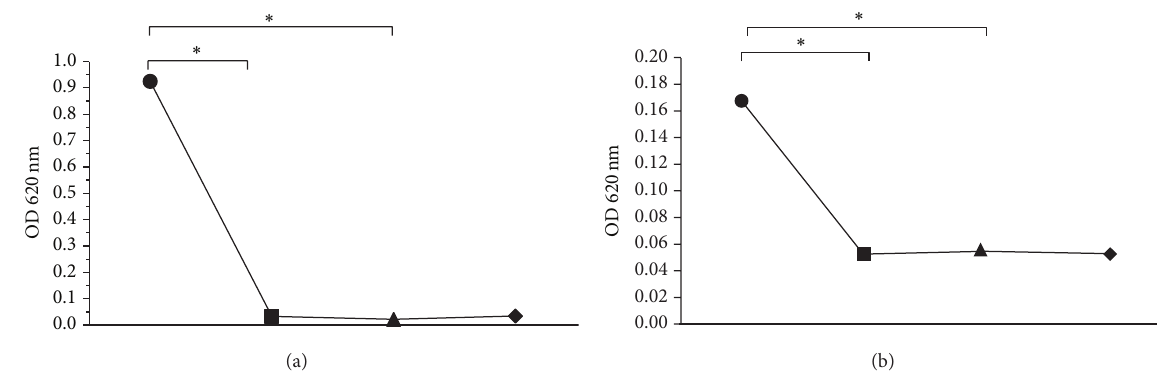
Figure 1: Bacterial sensitivity assays of Mammea americana extract. (a) Sensitivity of Porphyromonas gingivalis (ATCC 33277) to oily and ethanolic phases; exposure of P. gingivalis to mamey extract inhibited bacterial growth by approximately 96%. (b) Sensitivity of Streptococcus mutans (ATCC 25175) to mamey extract; the two phases inhibited bacterial growth by approximately 31.5%. Each symbol represents the mean for the group ( 𝑛 = 6 per group); inoculum: ( e ), oily phase (500 𝜇 g/mL): ( ◼ ), ethanolic phase (500 𝜇 g/mL): ( 󳵳 ), control (gentamicin (16 𝜇 g/mL)): ( X ), and 𝑃 value < 0.05: ( ∗ ); Kruskal-Wallis test and Dunnett’s